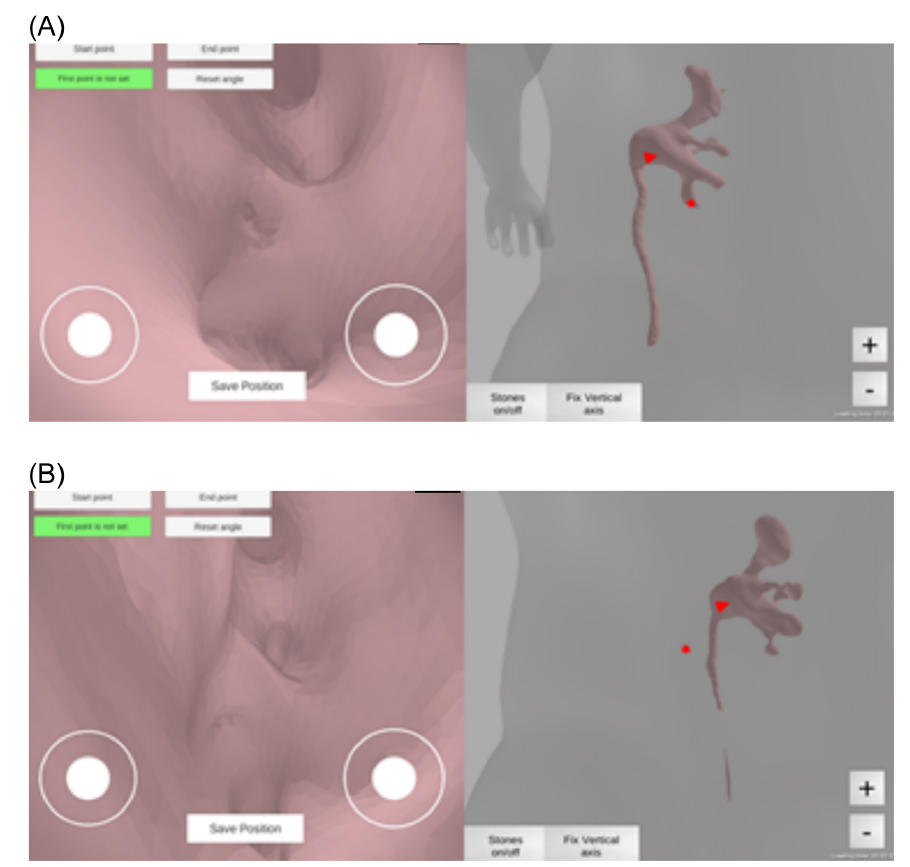
Figure 3. A, B. Reconstruction of the virtual endoscopic view based on contrast (A) and non-contrast (B) 3D models confirming the appropriateness of the latter for this purpose. 3D, 3